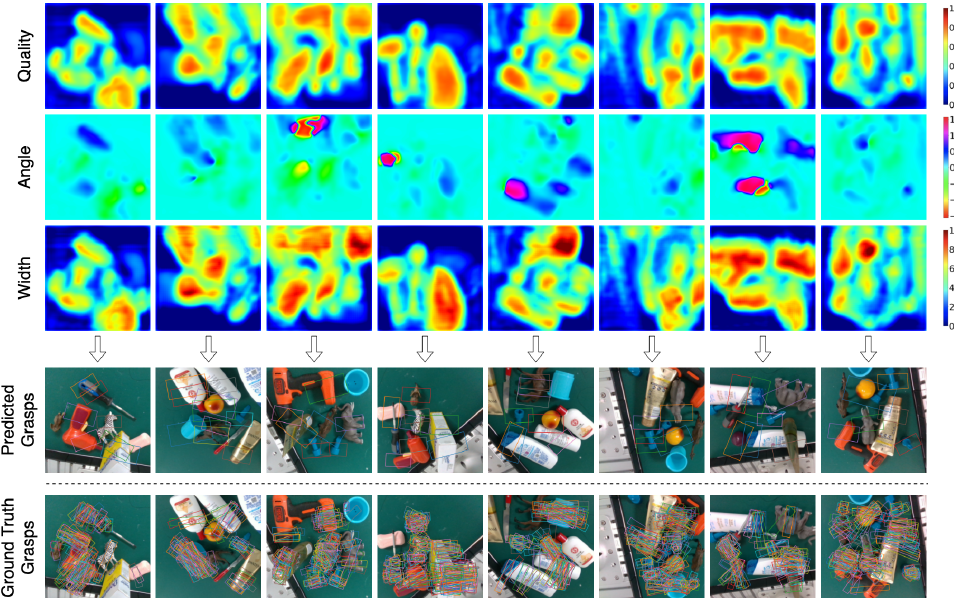
Figure 9. Qualitative results on Graspnet 1-billion Dataset. The top three rows (quality, angle and width) are the output of GR-Convnet. The bottom two rows are the predicted and ground truth grasps in rectangle grasp representation.